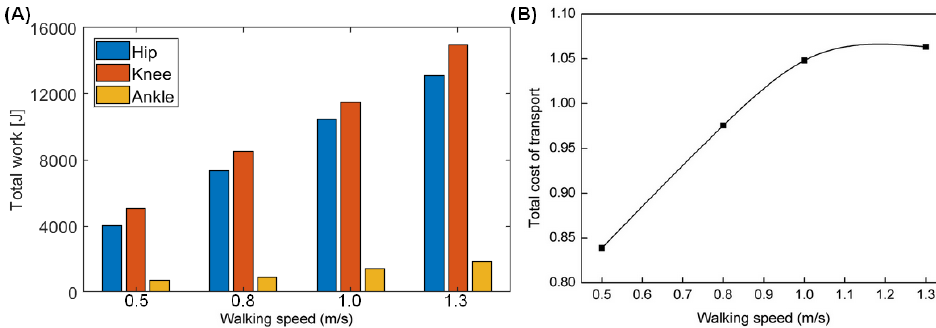
Figure 13. Energy use varies with the walking speed. ( A ) Total mechanical work; ( B )